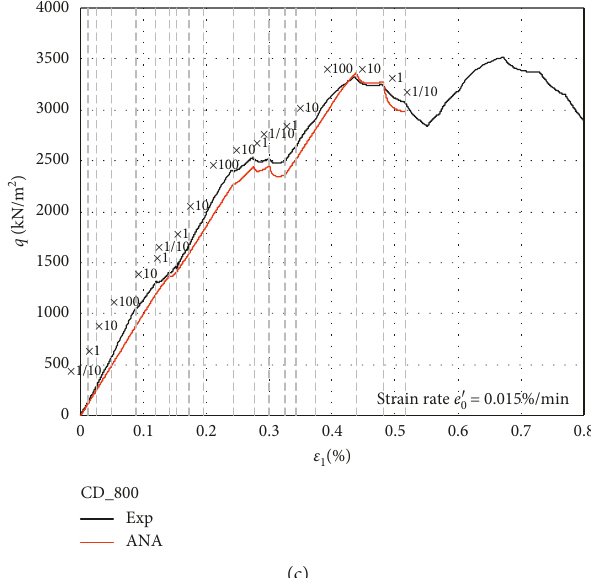
Figure 12: Deviatoric stress versus axial strain of the simulation of the CD test by the double hardening model for multiple strain rates under confining stresses of (a) 100kPa, (b) 400kPa, and (c)